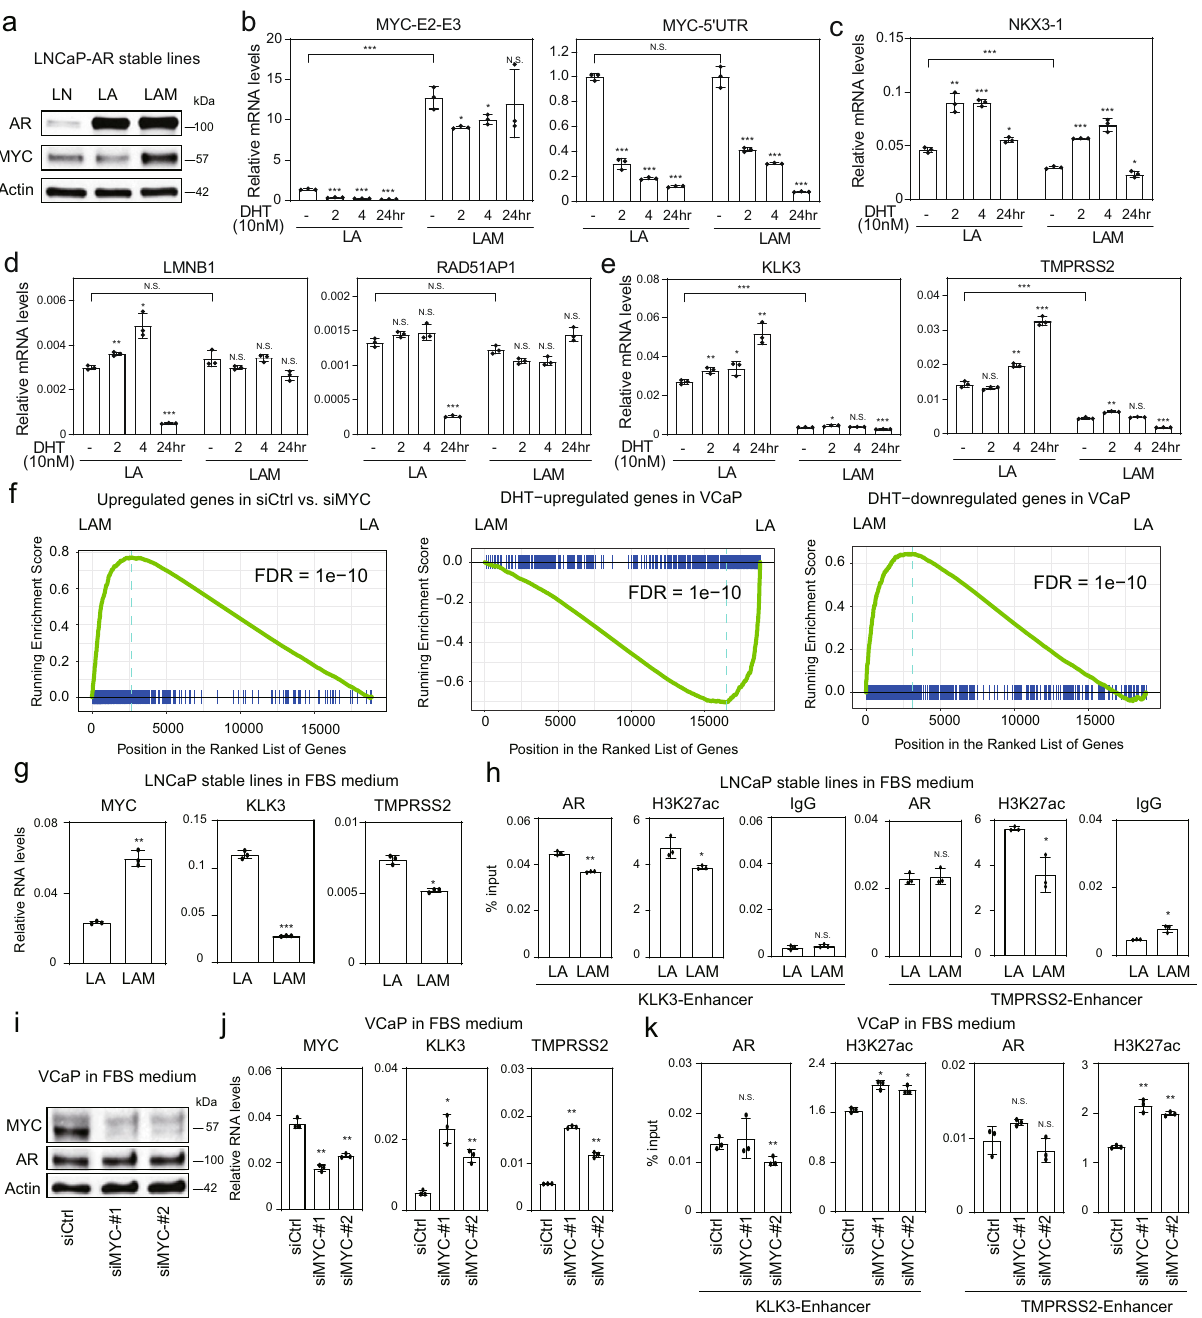
(Fig. S5a, b). We also assessed a novel AR degrader (ARCC-32, CC) that targets the AR for ubiquitylation and degradation 28 , which similarly induced MYC expression at both mRNA and protein levels (Fig. 5b,